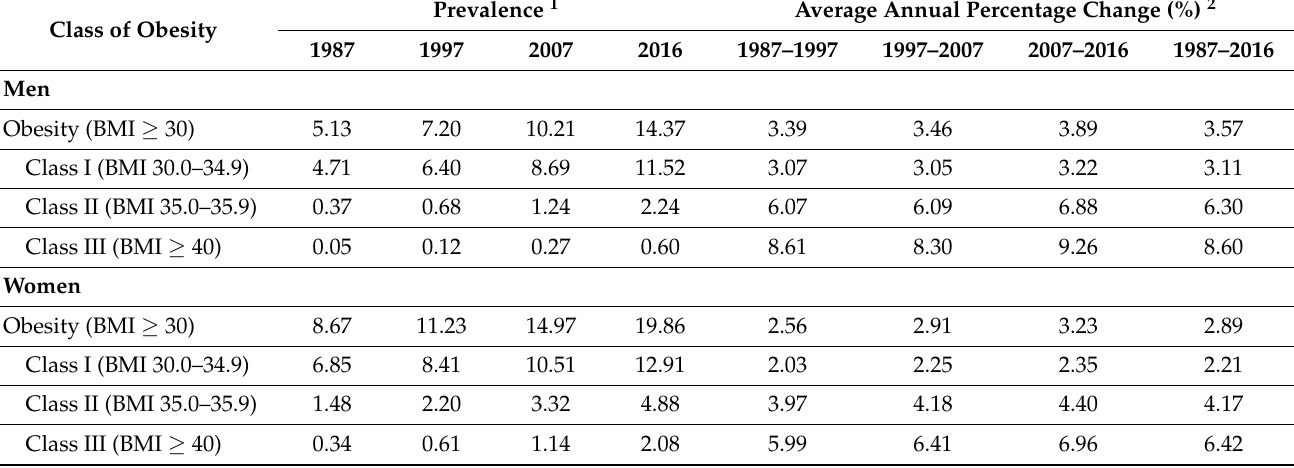
Table 1. Prevalence of obesity and its average annual percentage change in Uzbekistan between 1990 and 2019.